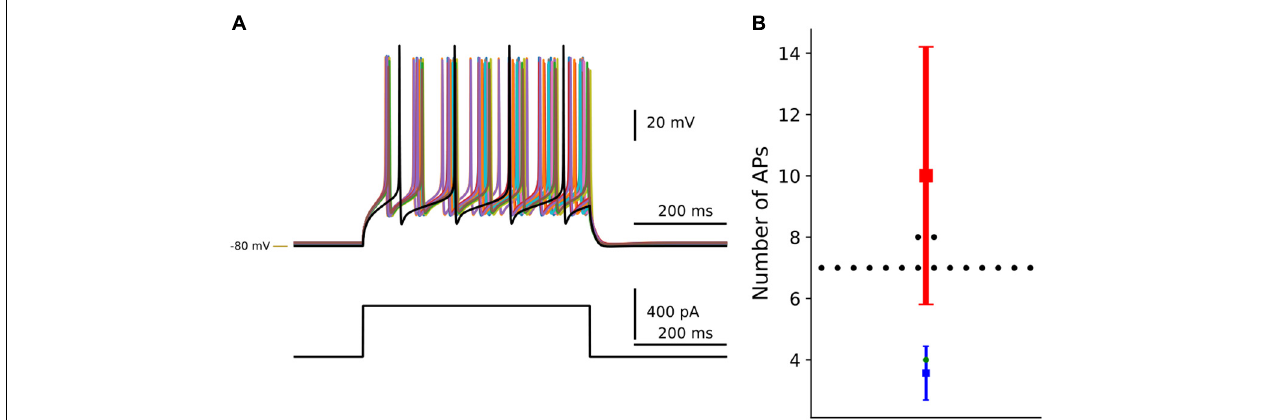
FIGURE 7 | Optimization of dopaminergic modulation of dSPN. By using the Neuromodcell package, parameter sets which reproduce the dopaminergic modulation are applied to the multicompartmental model of dSPNs. (A) Simulation of current clamp recordings of dSPN. Control simulation without dopamine modulation in black and dopamine modulated simulations which passed the selection criteria (non-black traces). (B) The change in the number of action potentials is compared to control (in green) and the parameter sets which passed in black. The mean and standard deviation of the control behavior from Planert et al. (2013) in blue, the DA modulated mean and standard deviation in red. –80 mV marked by yellow line.